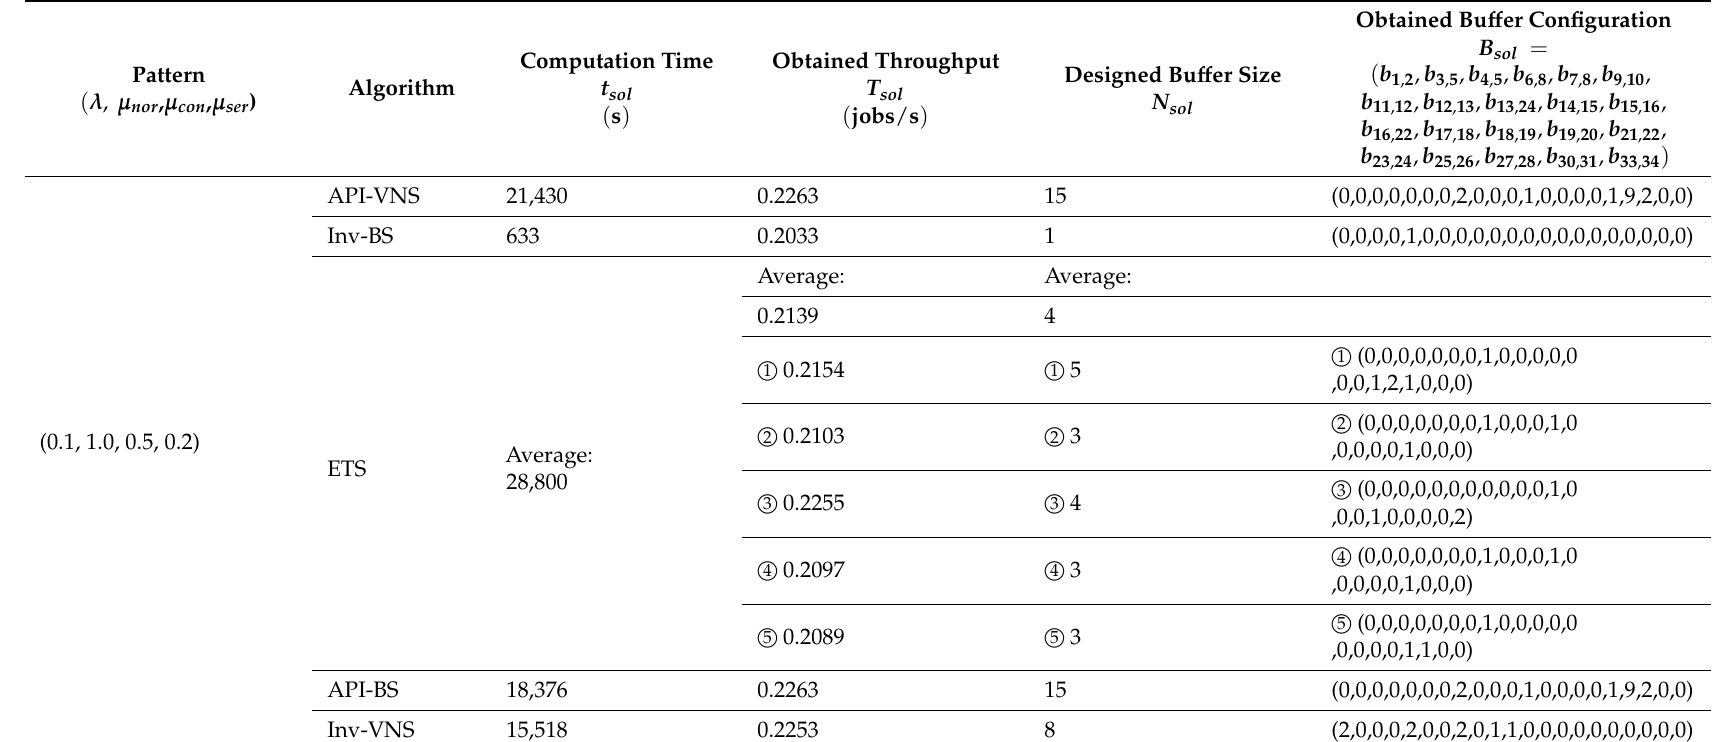
Table 5. Results of the five methods in experiment